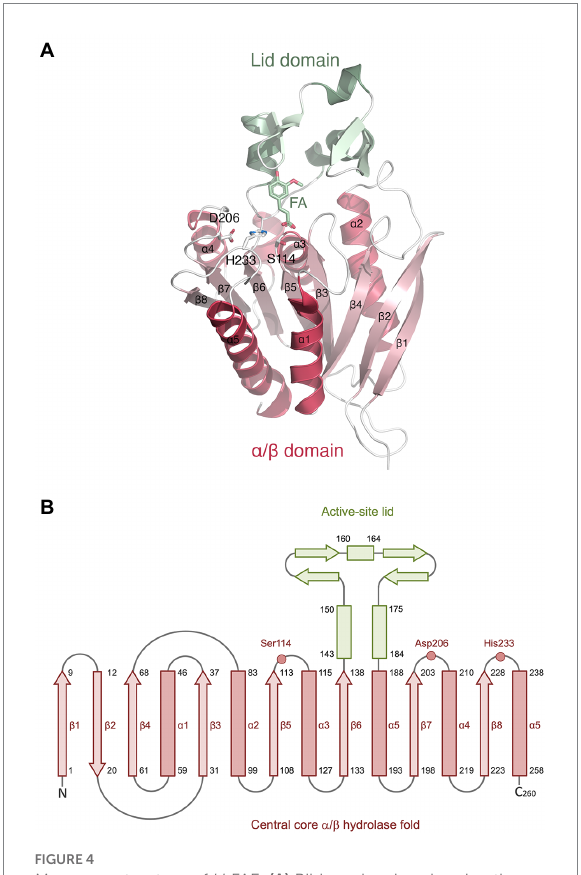
FIGURE 4 Monomer structure of Lb FAE. (A) Ribbon drawing showing the eight-stranded α / β hydrolase fold (red) and the lid domain (green). Ferulic acid (FA) and the side chains of the catalytic triad (Ser114, His233, Asp206) are shown as ball-and-stick objects. (B) Topology diagram showing the same information as in (A)